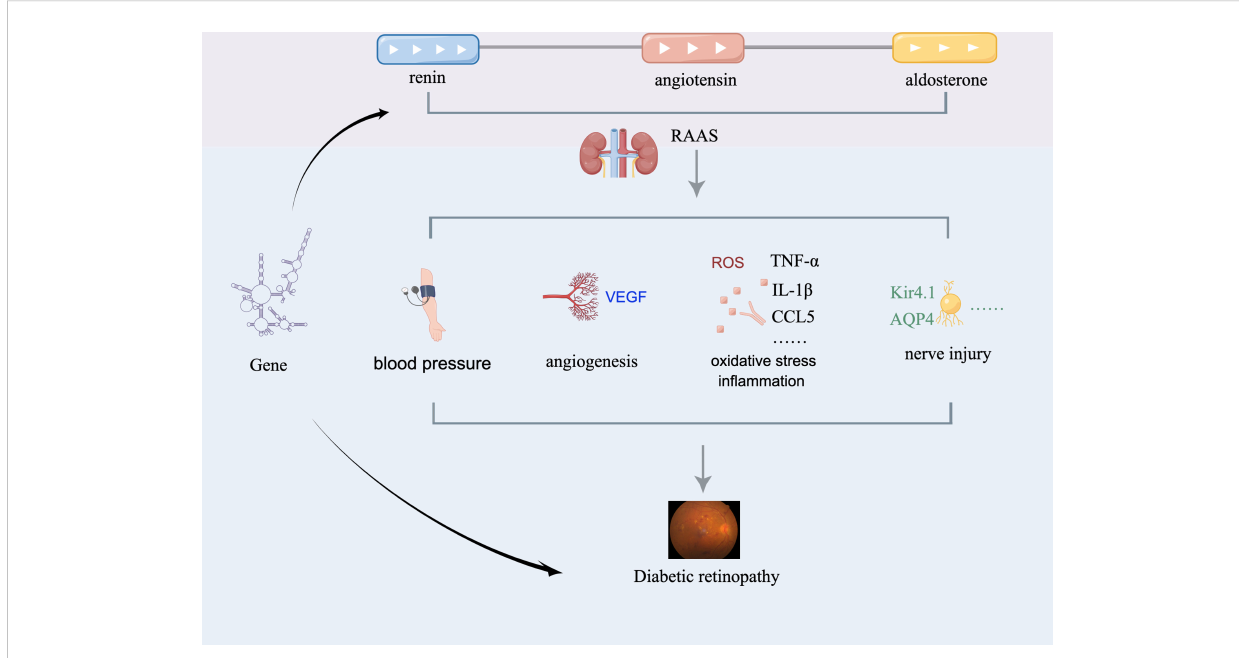
FIGURE 1 Putative mechanism whereby aldosterone affects DR. RAAS, renin-angiotensin-aldosterone system; AQP4, aquaporin-4; Kir4.1, inward recti fi er potassium channel